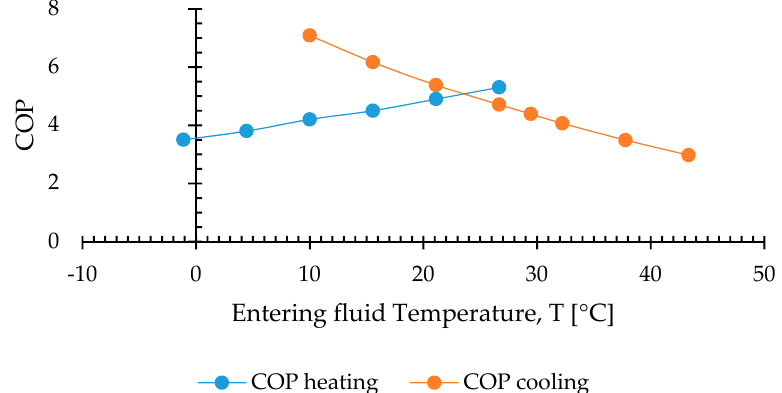
Figure 7. Heat pump COP in accordance with the entering fluid temperature, derived from manufacturers’ catalog.